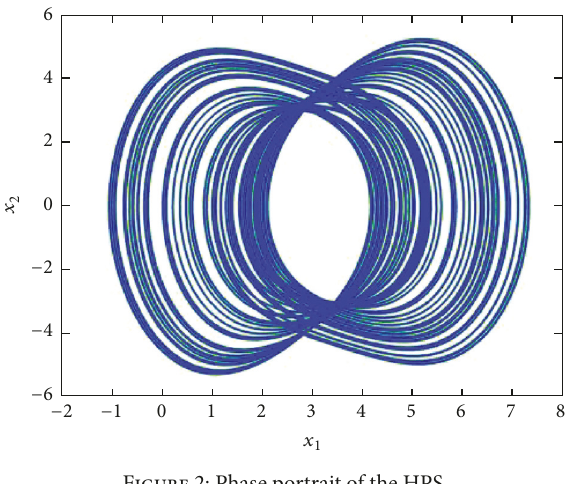
Figure 2: Phase portrait of the